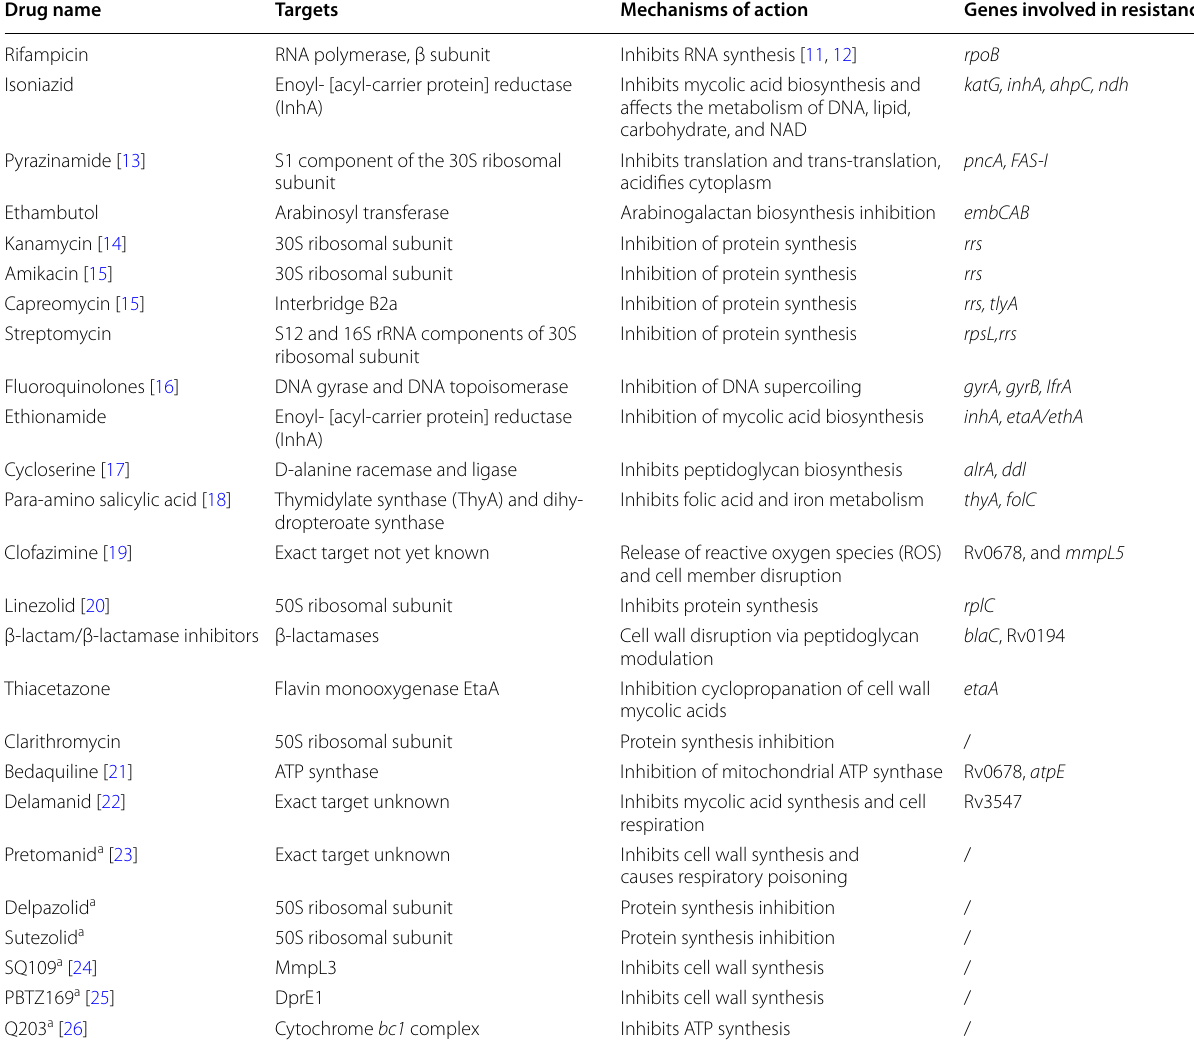
Table 1 An overall summary of available anti-tuberculosis drugs and their